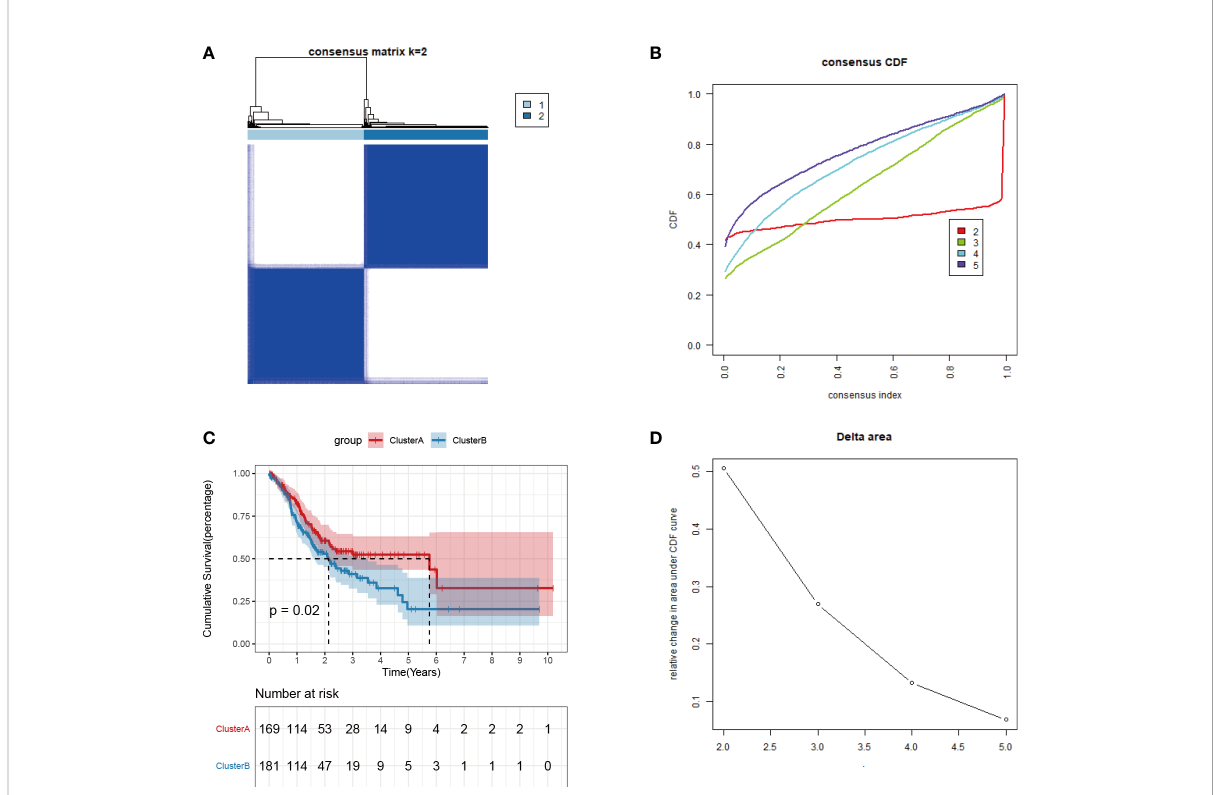
FIGURE 4 Consistent clustering of tumor angiogenesis-related gene expression pro fi les. (A) Distribution of consensus cumulative distribution function; (B) Cumulative distribution function delta curve; (C) Distribution of consensus matrix k=2; (D) Prognostic features of two DNA methylation